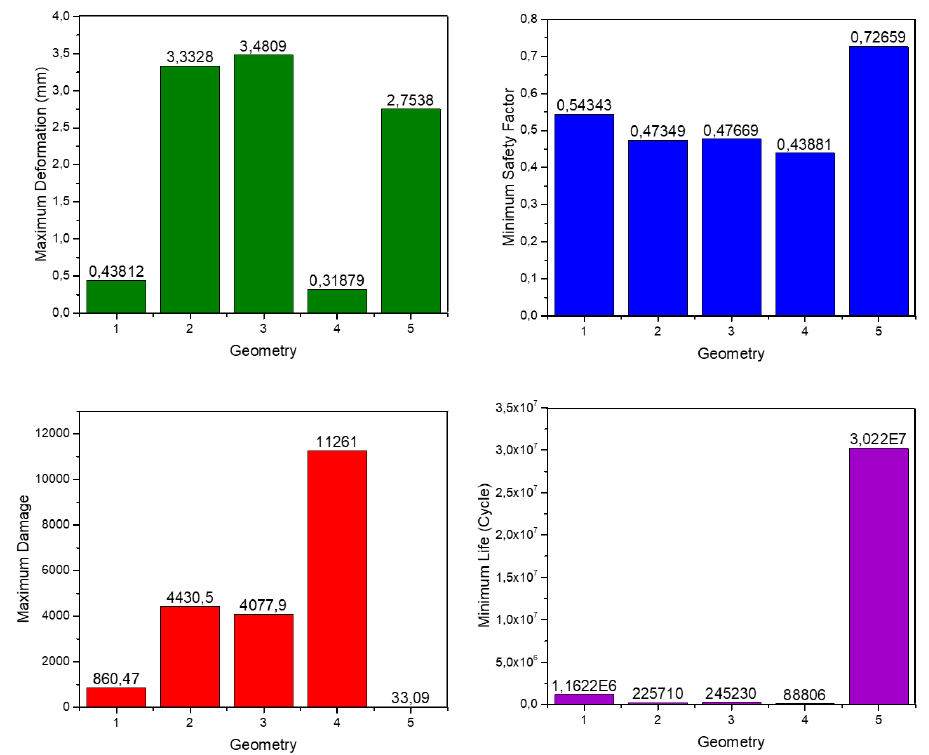
Figure 17. Fatigue Results: Maximum Deformation, Minimum Safety Factor, Maximum Damage, and Minimum Figure 17: Fatigue results: Maximum deformation, minimum safety factor, maximum damage, and minimum Life